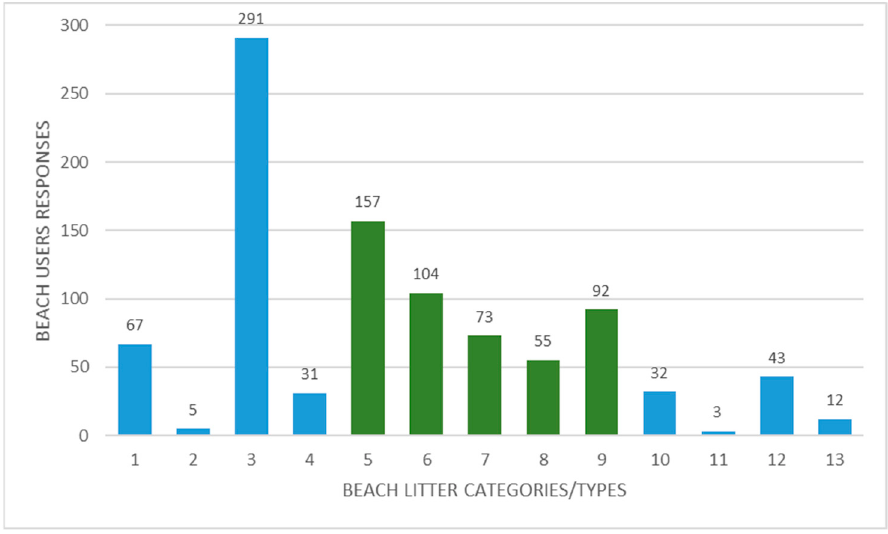
Figure 3. Litter categories/types identified from the users’ survey. See Table 4 for litter types. Table 4. Beach litter assessment